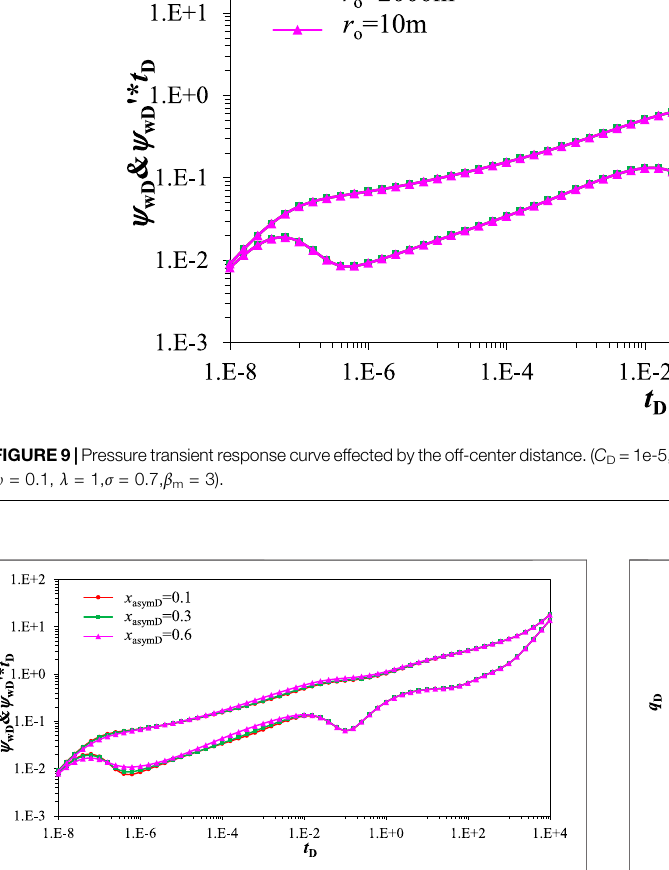
FIGURE 10 | Pressure transient response curve effected by asymmetry factor. ( C D =1e-5, S =0.01, L F =150 m, θ F =90 o , C FD =10, R e =3000 m, r o = 2000 m, ω = 0.1, λ = 1, σ = 0.7, β m = 3).